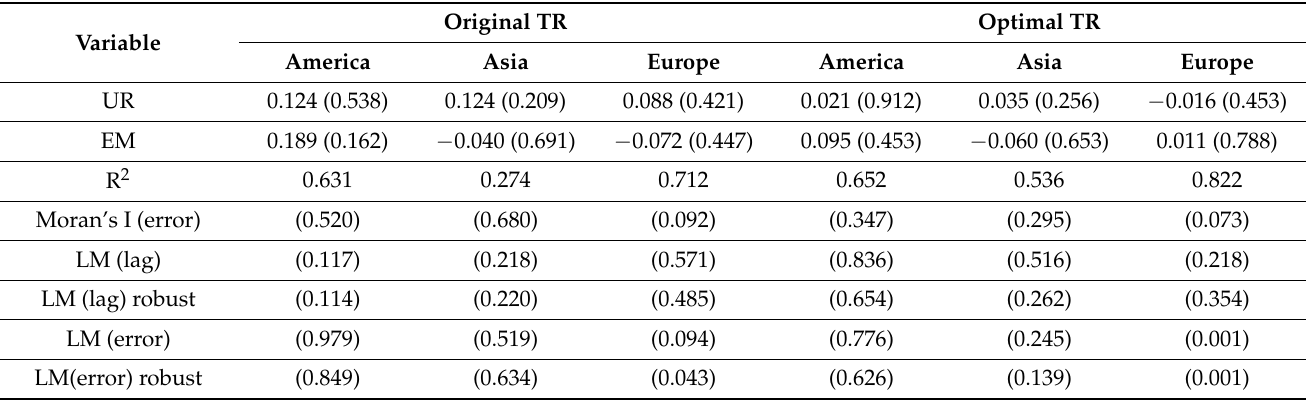
Constant calculated but not reported; p -value is given in parentheses.